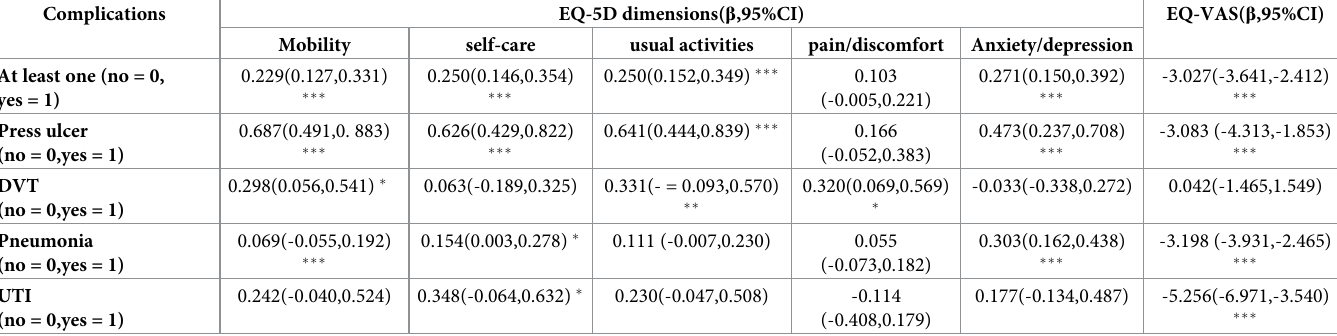
Table 3. The adjusted effect of MCI on EQ-5D dimensions and EQ-VAS in relation to total and separated complications based on multilevel mixed-effects model (n = 18391). Complications EQ-5D dimensions( β ,95%CI) EQ-VAS( β ,95%CI) Mobility self-care usual activities pain/discomfort